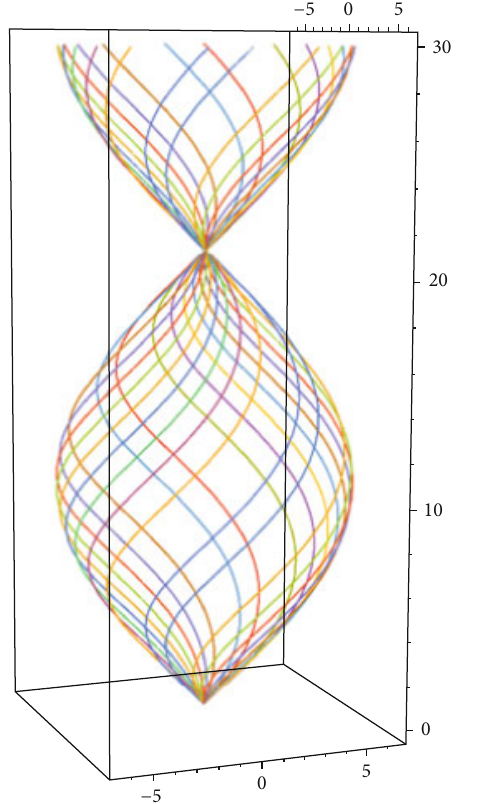
Figure 7: The future light cone of a point at the origin suppressing the ̂ z direction. The ̂ x – ̂ y positions of light rays with p plotted against the a ffi ne parameter s on the vertical axis.